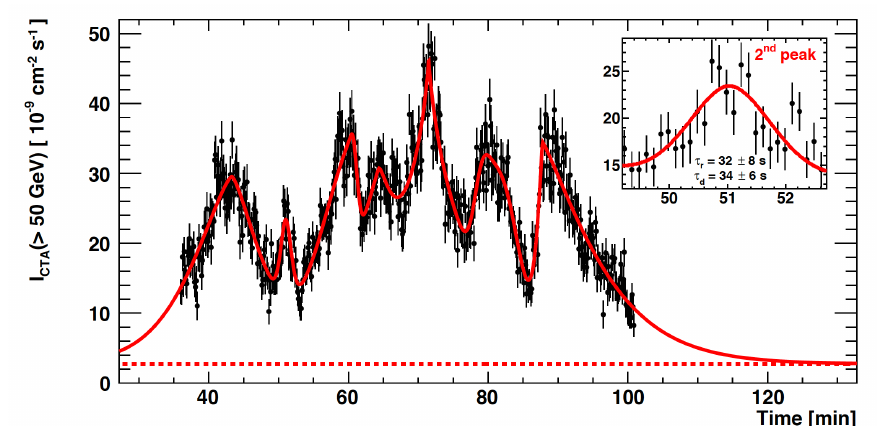
Figure 2. Simulated CTA light curve based on an extrapolation of the power spectrum for the strong 2006 VHE flare of the blazar PKS 2155-304. CTA will allow probing sub-minute timescales (see inlay) and thereby help to discriminate between different physical models. From